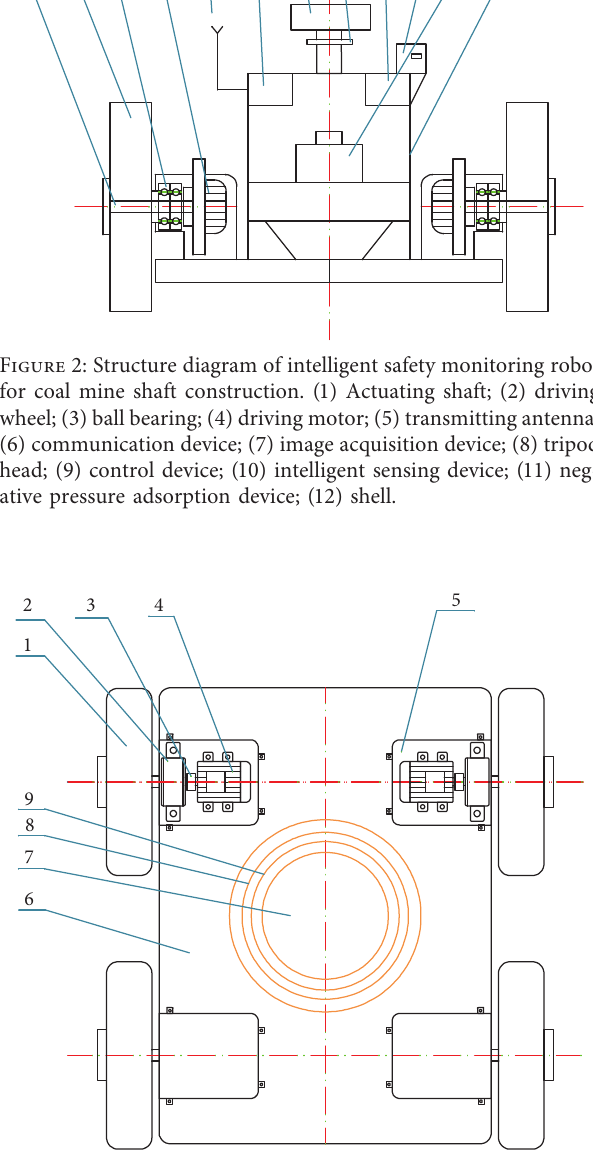
Figure 3: Bottom structure diagram of intelligent safety monitoring robot for coal mine shaft construction. (1) Driving wheel; (2) bearing pedestal; (3) actuating shaft; (4) driving motor; (5) motor base; (6) shell; (7) adsorption disc; (8) gasket 1; (9) gasket